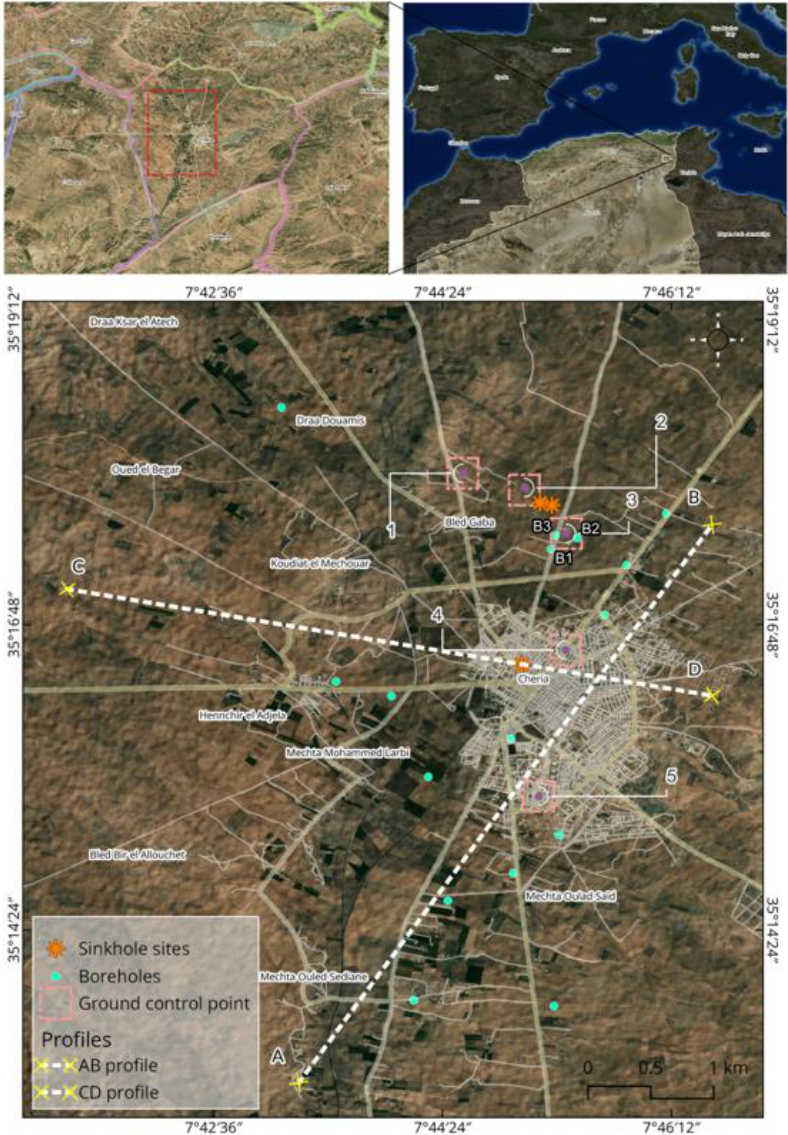
Figure 1. Location map of the study area (background image: Landsat-8 OLI dated September 12, 2022). Orange stars are past sinkhole sites; B1, B2, and B3 are borehole wells where the water level was monitored; pink rectangular boxes are the location of ground control points; and dashed white lines are profiles selected for the analysis of PSI and GPS results.